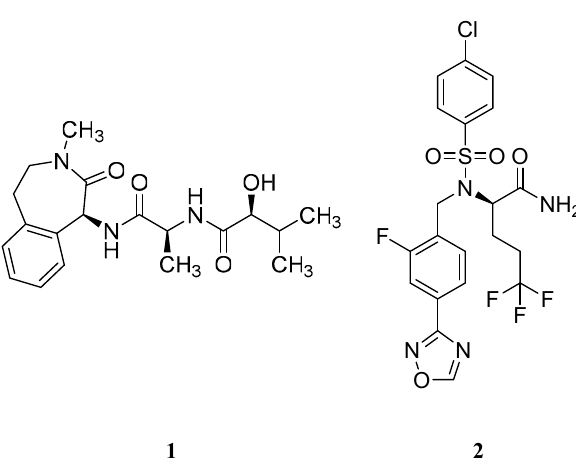
Figure 6. (cid:903) -Secretase inhibitors ( 1 – 2 ) advanced in late-stage clinical trials. Figure 6. γ -Secretase inhibitors ( 1 – 2 ) advanced in late-stage clinical